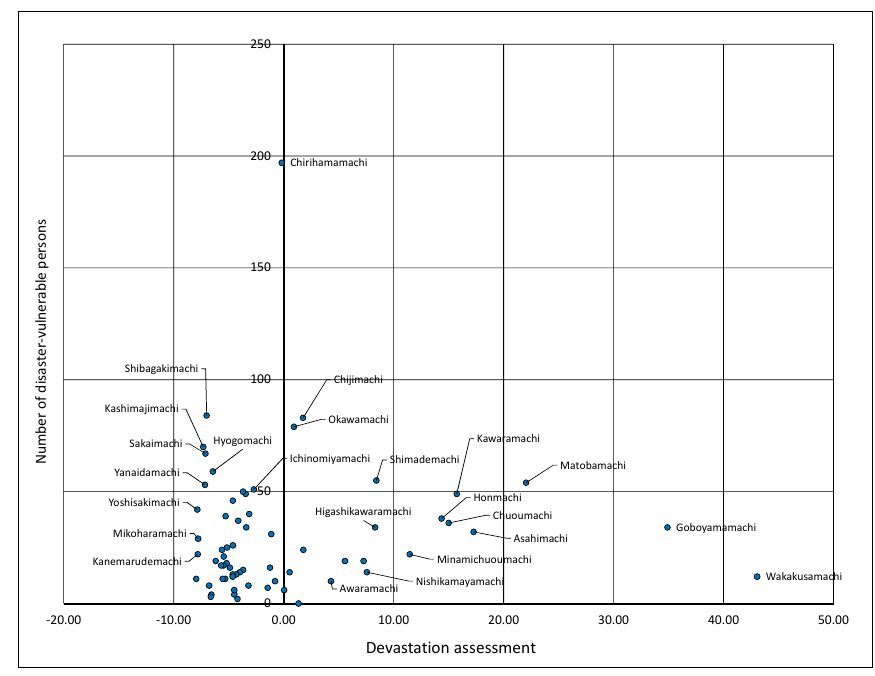
Figure 8. Relationship between the number of disaster-vulnerable persons and the devastation assessment.